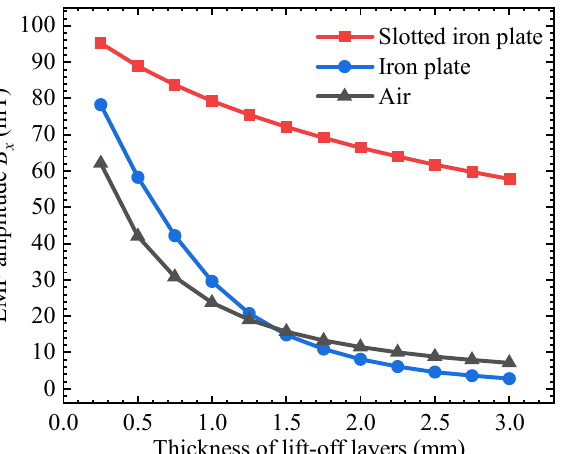
plate, iron plate, and air lift-off layer.